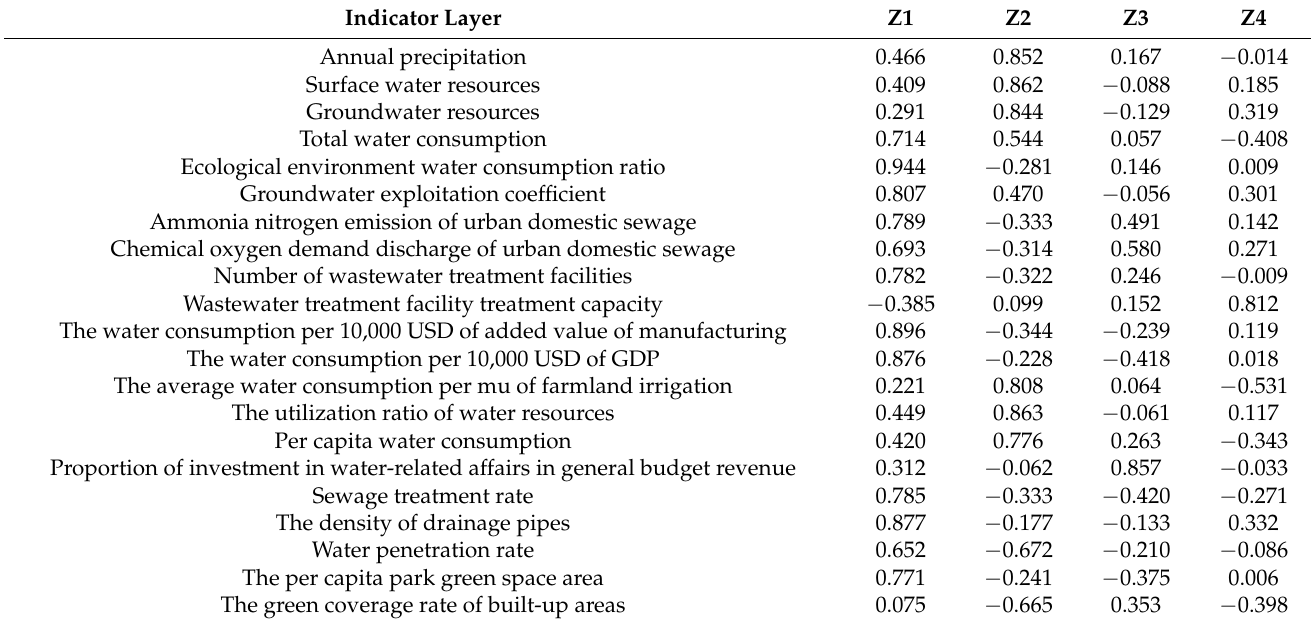
Table 4. The principal component factor loading